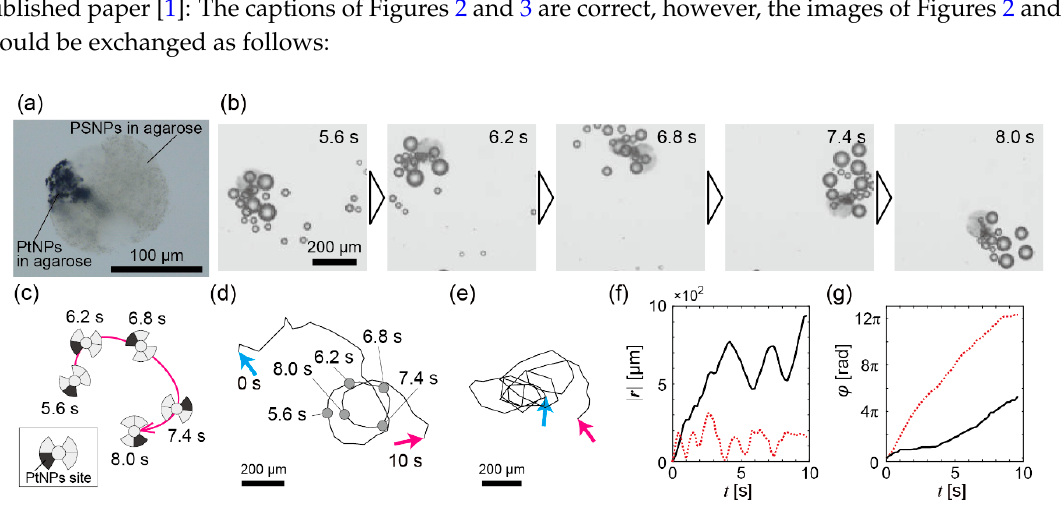
Figure 2. Experimental results of bubble propulsion of the propeller-shaped micromotors with a single catalytic site in the H 2 O 2 solution. ( a ) A microscope image of a propeller-shaped micromotor with a single catalytic site; ( b ) Time series from t = 5.6 s to t = 8.0 s of a propeller-shaped micromotor with a single catalytic site propelled by bubbles; ( c ) Schematic illustration of the trajectory of ( b ); ( d ) The whole trajectory of the micromotor in ( b ); Cyan arrow: t = 0 s; magenta arrow: t = 10 s; ( e ) The trajectory of another micromotor. The notation of arrows is the same as in ( d ); ( f ) The time variation of | r ( t )|. Black solid line: For the trajectory of ( d ); red dashed line: For the trajectory of ( e ); ( g ) The time variation of ϕ ( t ) . The notation of each line is the same as in ( f )